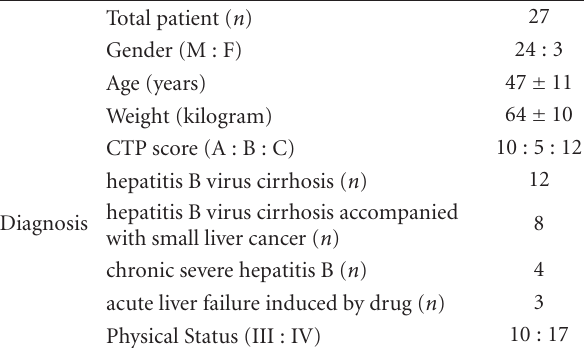
Table 1: Basic characteristics of the study